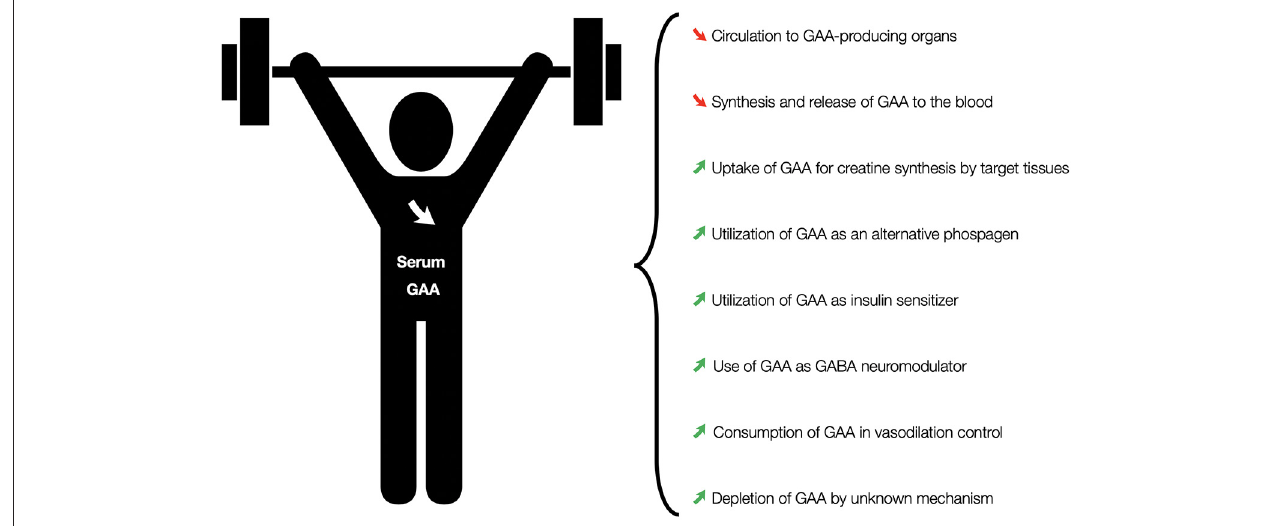
FIGURE 1 | Possible mechanisms involved in exercise-induced changes in serum GAA